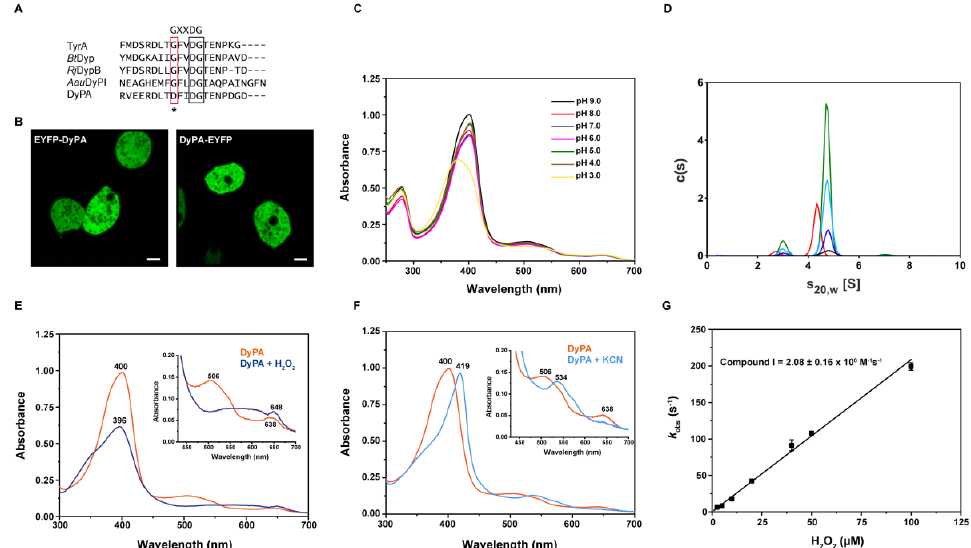
Figure 1. Cellular localization and biochemical properties of Dictyostelium DyPA. ( A ) Multiple se- quence alignment of conserved GXXDG motif of different DyP-type peroxidases. Conserved glycine of the GXXDG motif is shown in a red box and DG in a black box. The asterisk (*) marks the position where the substitution of the first conserved glycine residue by aspartate (D146) occurs in Dictyoste- lium DyPA . ( B ) Confocal images of live Dictyostelium discoideum cells show the cytoplasmic localiza- tion of fusion constructs EYFP-DyPA and DyPA-EYFP; scale bars 5 µm. ( C ) Electronic absorption spectra of Dictyostelium DyPA at different pH. ( D ) Characterization of the oligomerization state of Dictyostelium DyPA by analytical ultracentrifugation. Sedimentation velocity runs at 50,000 rpm and 20 °C were performed with the following concentrations of Dictyostelium DyPA 2.1 µM (black), 6.3 µM (blue), 18.9 µM (light blue), and 33.6 µM (green) and 20 µM apo- Dictyostelium DyPA lacking the heme cofactor (red) respectively. Independent of the protein concentration, the main fraction of Dictyostelium DyPA sediments as a dimer with s 20,w = 4.8 S. At low heme saturation, the sedimenta- tion coefficient decreases to 4.3 S, indicating the formation of Dictyostelium DyPA dimers with a less compact shape. ( E ) The electronic absorption spectrum of Fe III - Dictyostelium DyPA and compound I. Spectra of 10 µM Dictyostelium DyPA in the absence (orange) and presence (blue) of 10 µM H 2 O 2 . The inset displays Q and CT bands. ( F ) Electronic absorption spectra of 10 µM Dictyostelium DyPA in the absence (orange) and presence (light blue) of 5 mM KCN. Q and CT-bands are shown in the inset. ( G ) Stopped-flow analysis of the association of H 2 O 2 with the Dictyostelium DyPA. The slope of the observed rate constants ( k obs ) plotted against the H 2 O 2 concentration defines the second-order rate constant for compound I formation as 2.08 ± 0.16 × 10 6 M −1 s −1 .